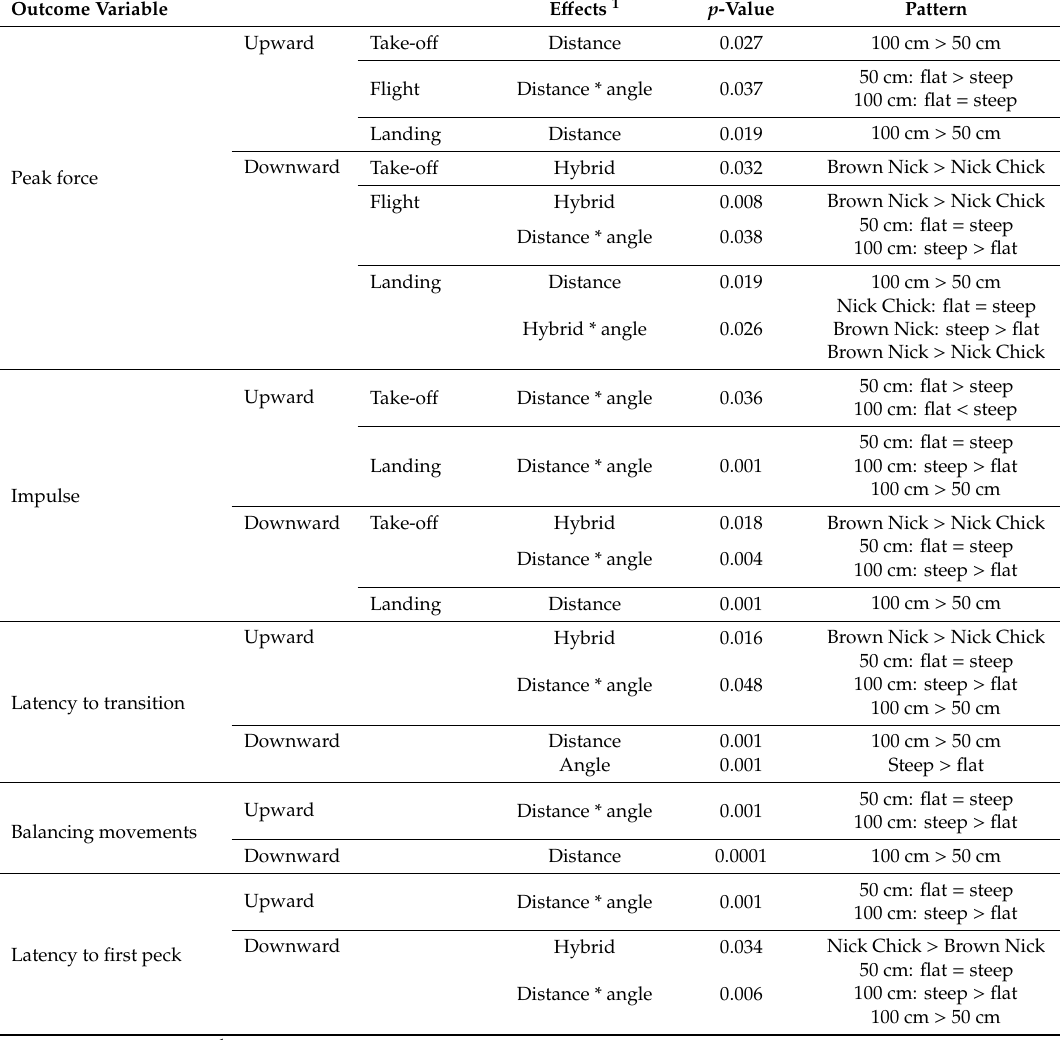
Table 2. Overview of results including outcome variables, the variables remaining in the model after stepwise-backwards reduction (E ff ects), p -values for each variable or interaction, as well as the pattern in the